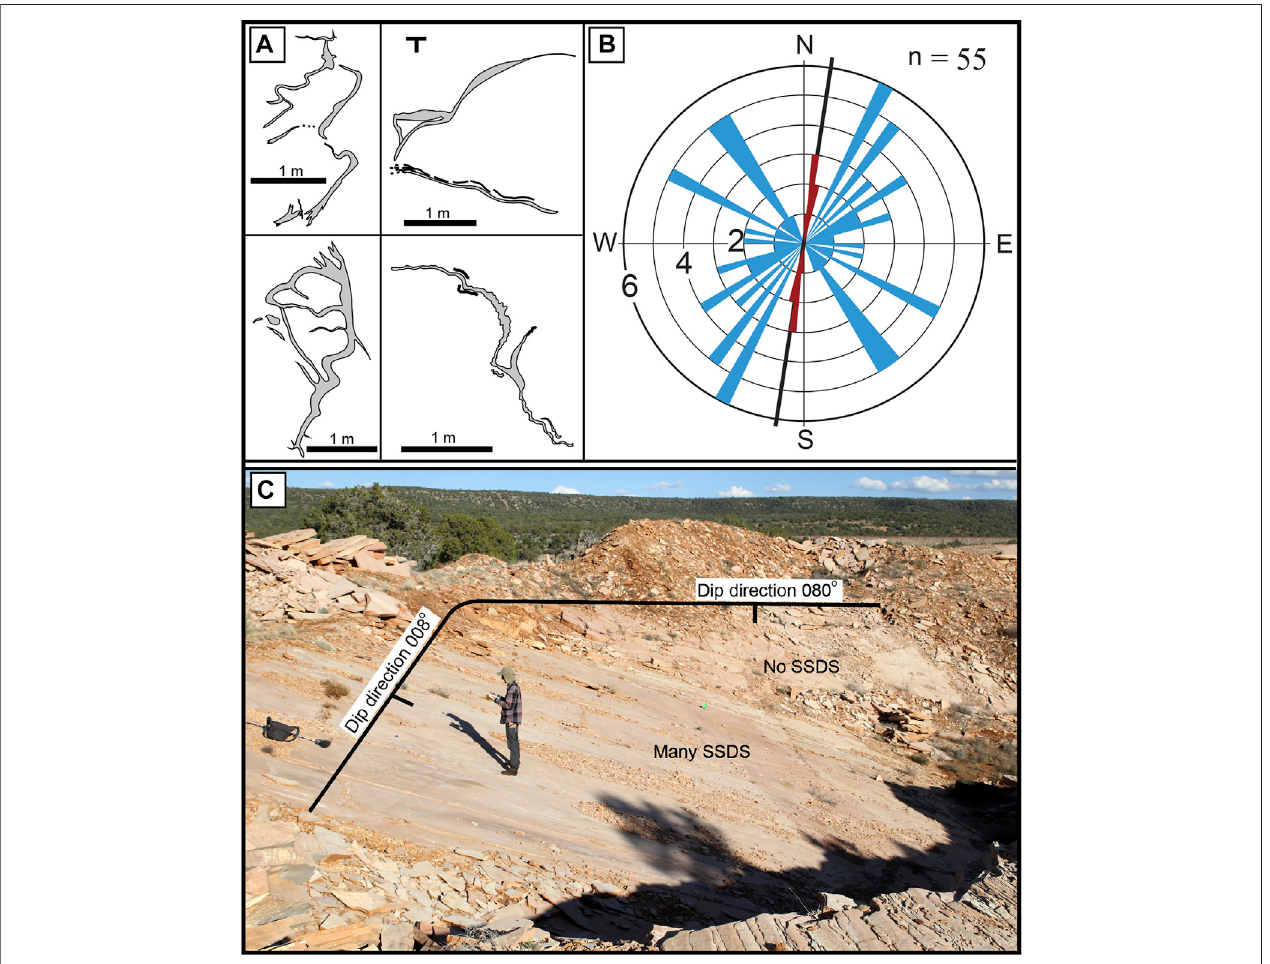
FIGURE 7 | (A) Examples of complex folds on Coconino Sandstone foreset beds, drawn in plan view. The structures in these drawings are raised folds or ridges (also shown in Figure 3 ). Cross-beds dip 18 – 25 ° toward the bottom of each image. (B) Fold-axis orientation of deformation structures from Ash Fork quarry 25 (also picturedin Figure 8 ).Blue:SSD ≤ 2.5 m long.Red: SSD 3.5 – 10 m long.The black linerepresents the cross-bed dip direction, toward thebottom ofthediagram. n (cid:1) 55 simple folds or segments of 11 complex folds. (C) Sharply curved cross-bed surface at Ash Fork quarry 25. SSDSs are abundant on the left side (8 ° dip direction; 196 sq m of surface), but absent on the right side (80 ° dip direction; 35 sq m of surface). Height of person (cid:1) 1.8 m (6